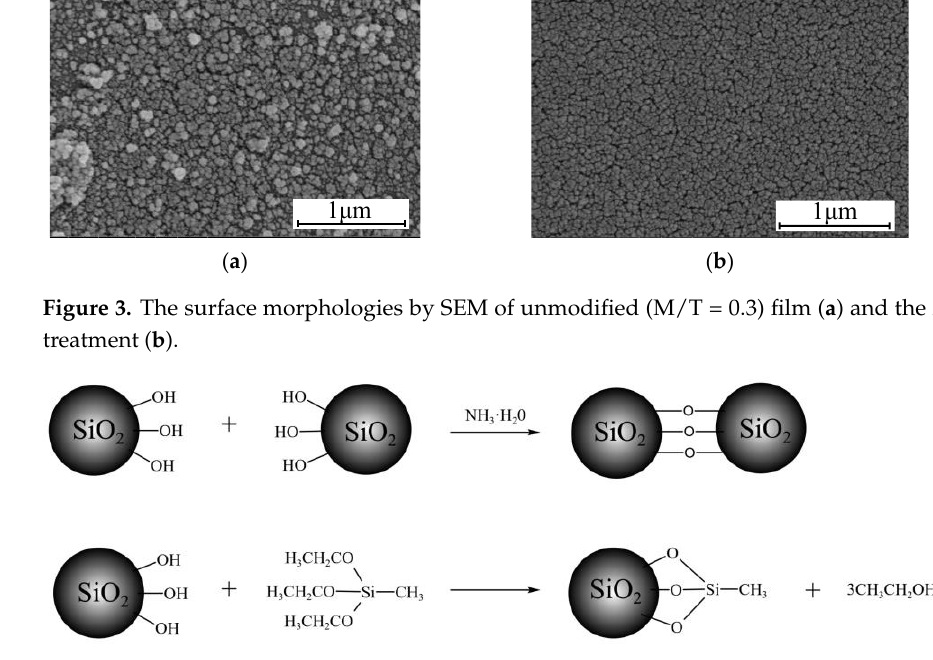
Figure 4. Schematic diagram of chemical reactions between SiO 2 film and MTES/NH 3 .